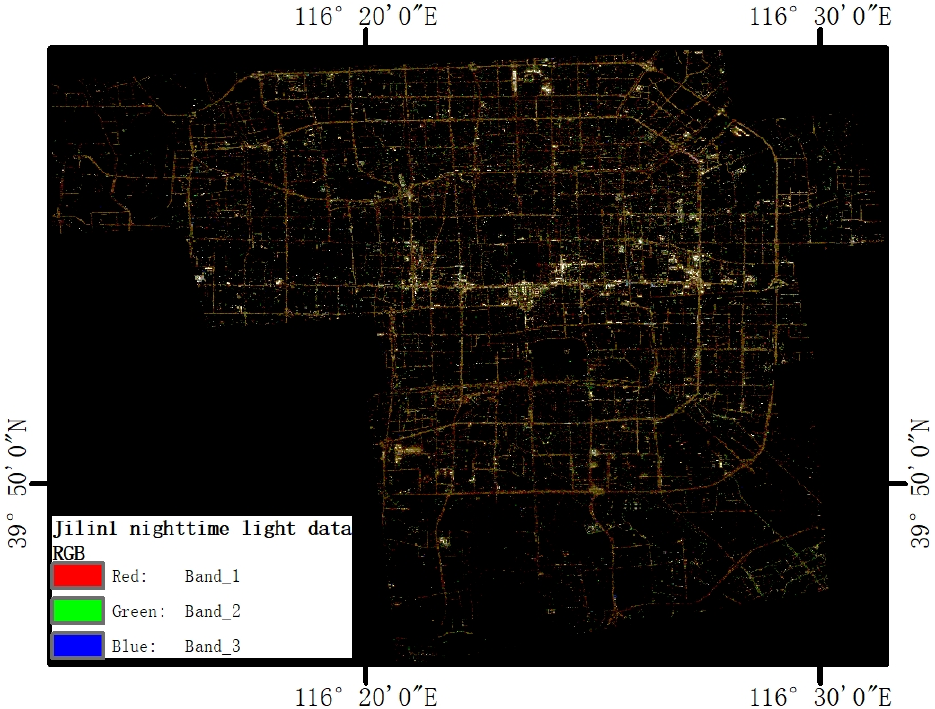
Figure 3. The Jilin-1 archived nighttime light remote sensing data of Beijing (data as of 2020).